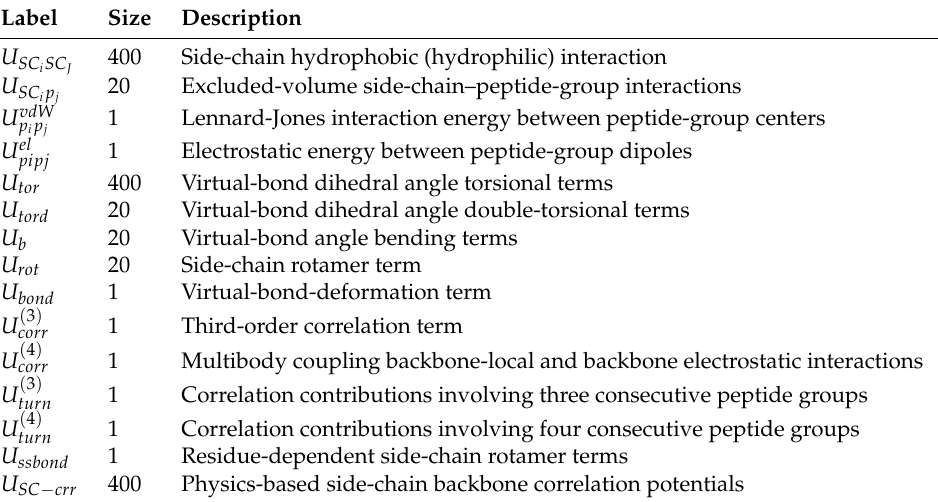
Table 2. Labels for UNRES